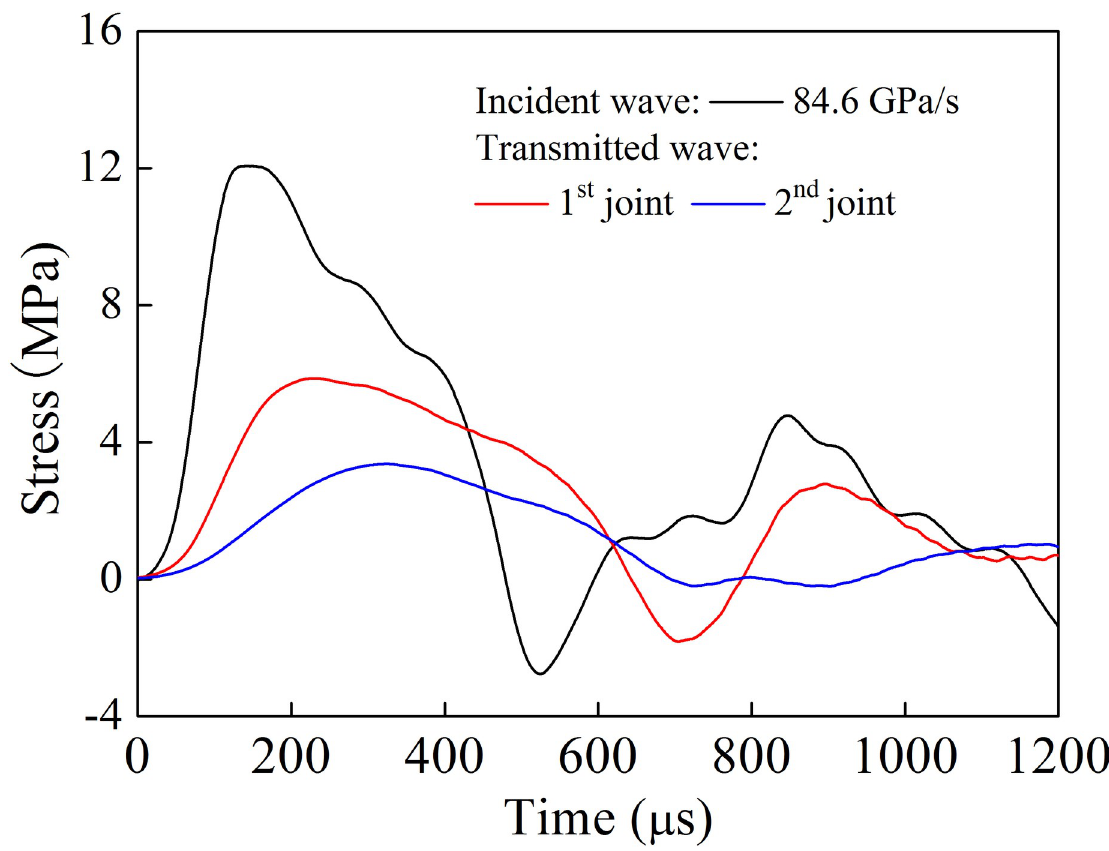
Fig 12. Stress time history curves in the bar with two joints ( d 1 = d 2 = 3